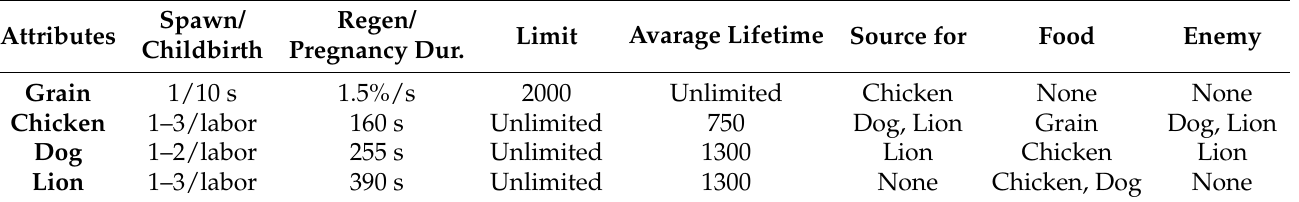
Table 1. Default attributes which are not affected by the aging mechanics. Here, only the Pregnancy duration attribute is affected by the evolution